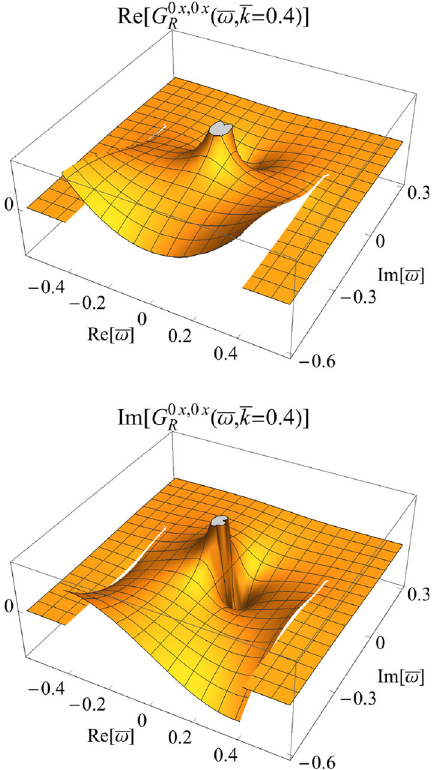
( ¯ ω, ¯ k ) , evaluated for ¯ k = R ( ¯ ω, ¯ k ) R